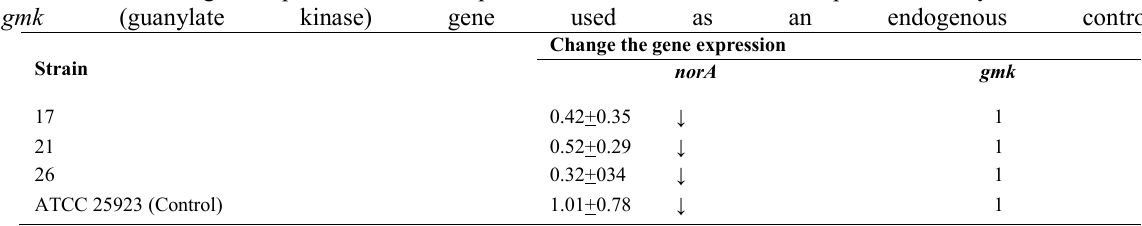
Table 4. The norA gene expression of three ciprofloxacin resistant strains in the presence of thyme extracts. The gmk (guanylate kinase) gene used as an endogenous